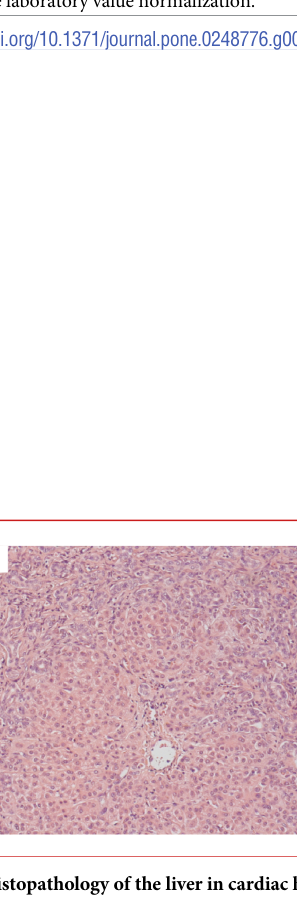
PLOS ONE | https://doi.org/10.1371/journal.pone.0248776 March 25,